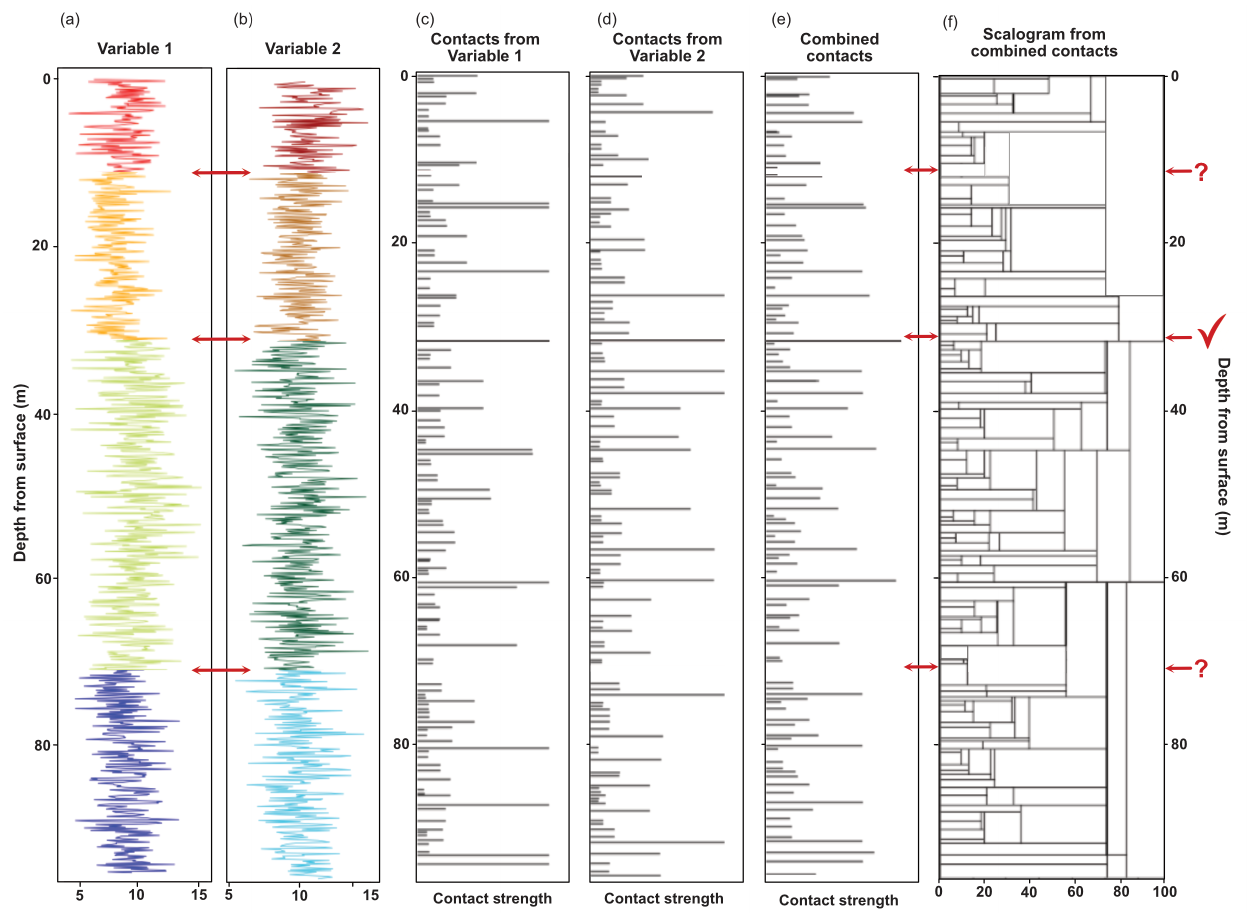
Figure 10. Results of the synthetic dataset using state-of-the-art methodology. ( a , b ) The two synthetic variables used as input data. The colour scheme of the variables in panels ( a , b ) is explained in Figure 3. ( c ) Contacts extracted from variable 1. ( d ) Contacts extracted from variable 2. ( e ) Combined contacts in the post-processing step. ( f ) Scalogram from combined